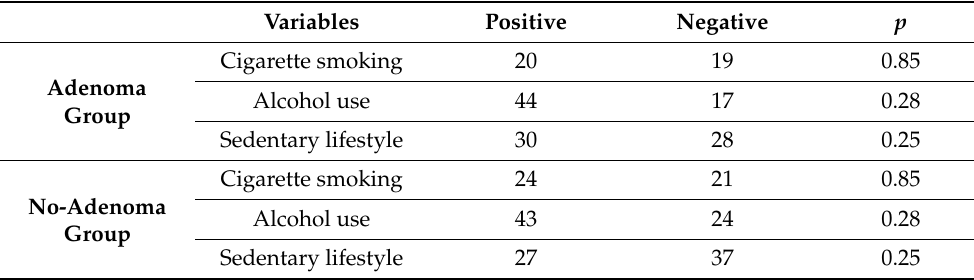
Table 4. Numeric distribution of patients with and without adenomas in relation to lifestyle. None of the number of subjects per variables significantly differs between the two groups. Variables Positive Negative p Adenoma Group